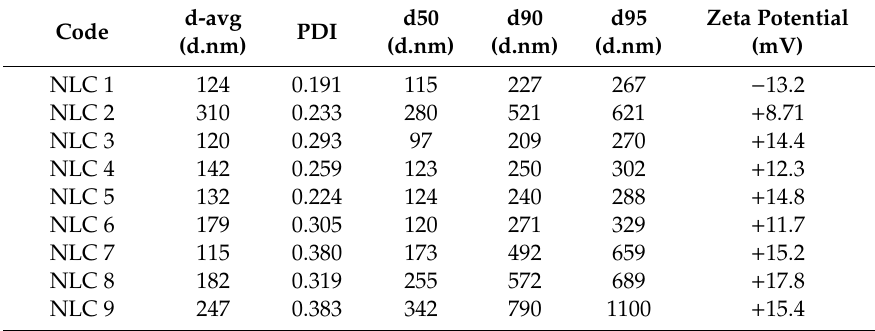
Table 2. Particle characteristics of the various NLC formulations for